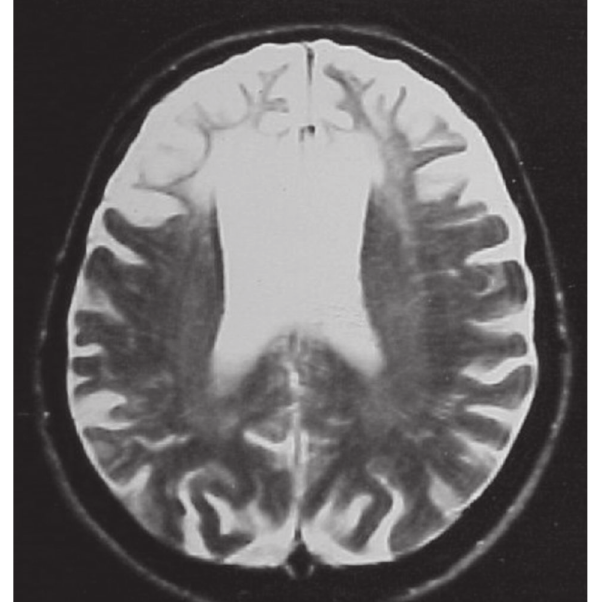
Figure 2. Case 2 – RM (T2 axial) showing bi lateral white matter hypointense signal, sug gestive of gliosis, restricted to frontal lobes.